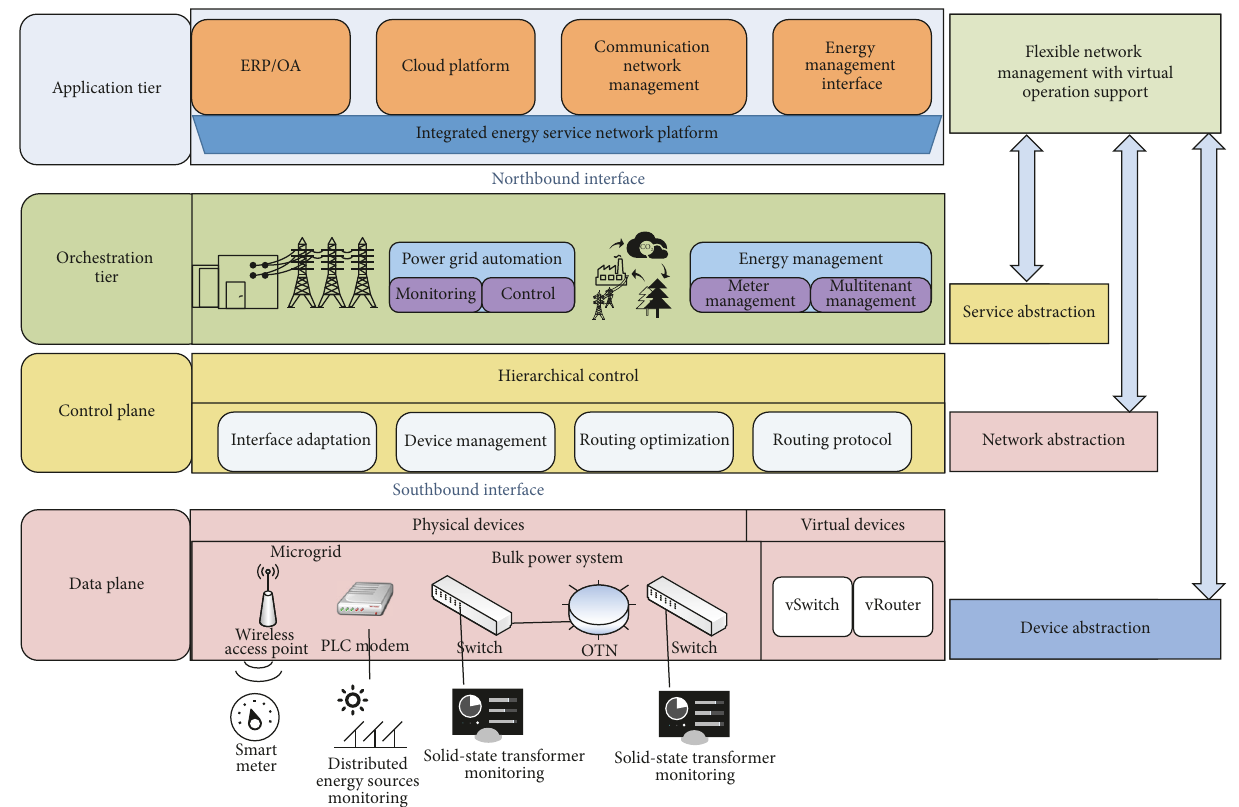
Figure 5: SDN-enabled communication network framework in energy